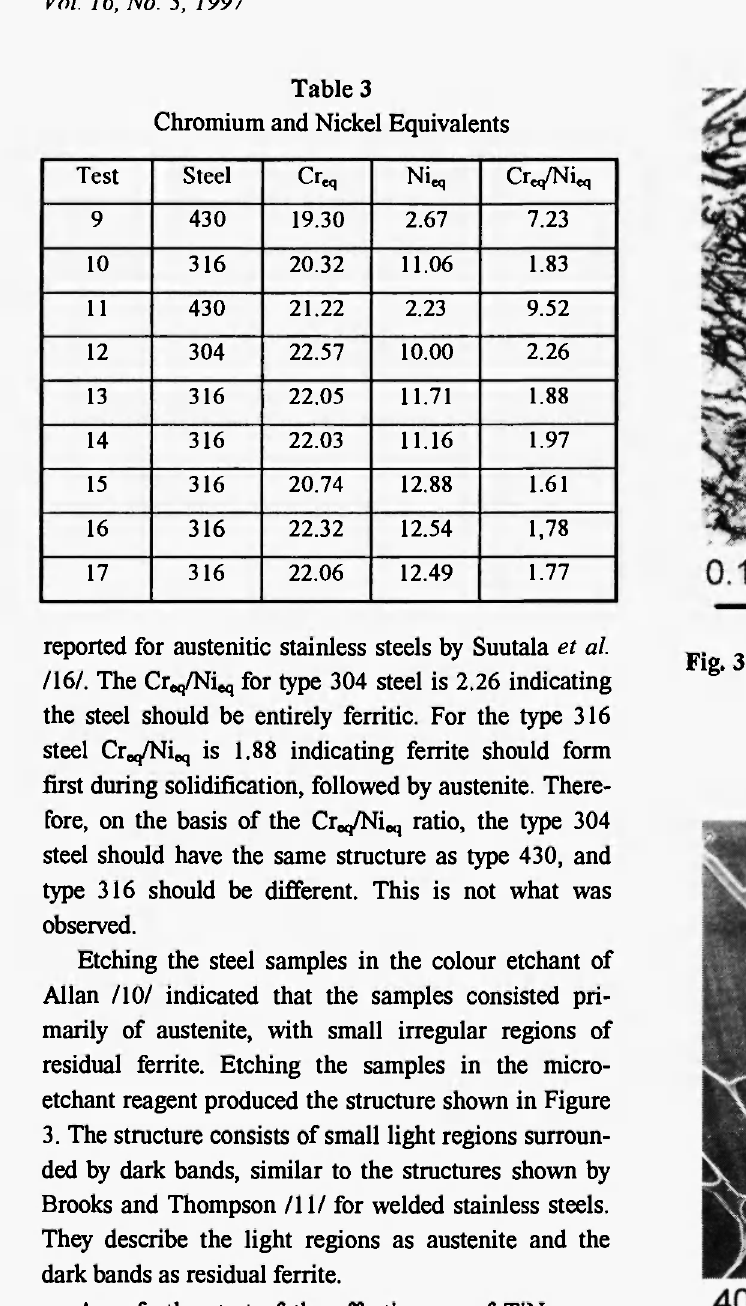
Etched surface of type 316 stainless steel